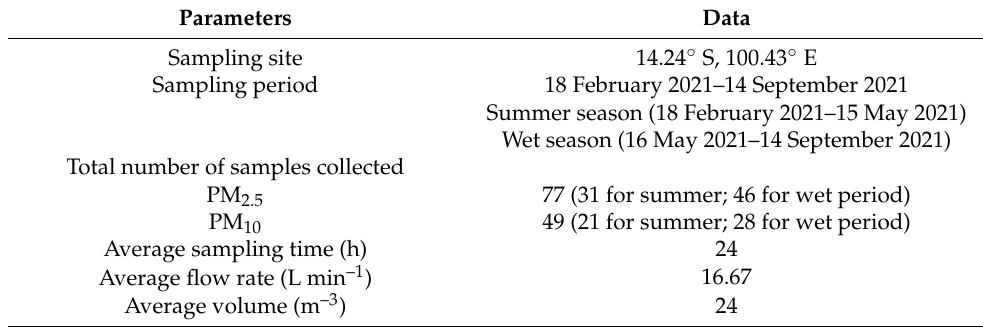
Table 1. Sampling